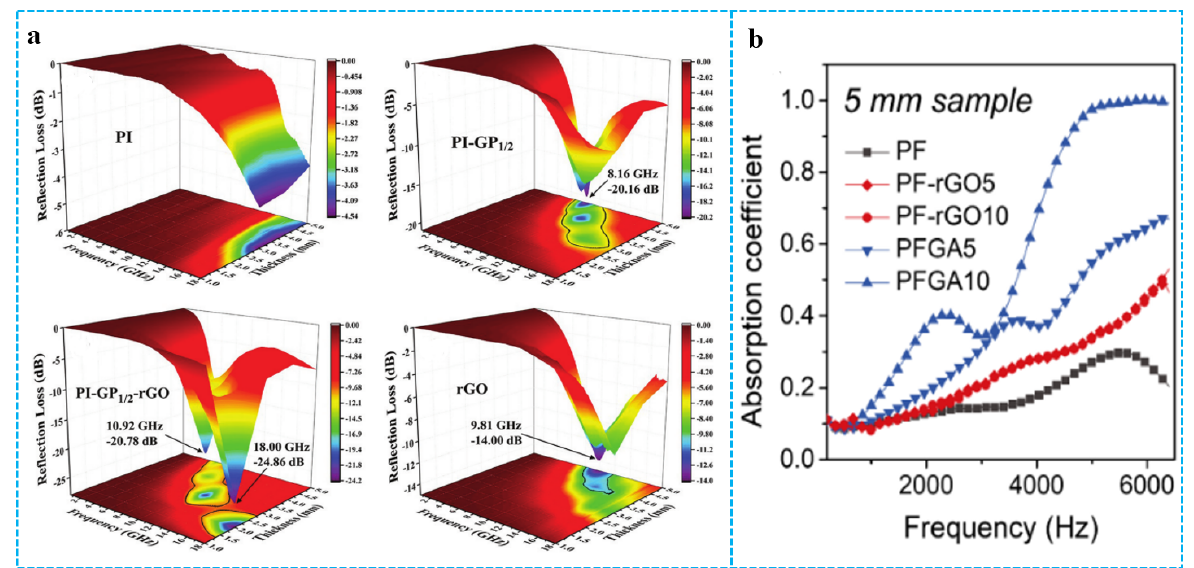
Figure 16. ( a ) 3D reflection loss maps of PI, PI − GP 1/2 , PI − GP 1/2 − rGO and RGO composite foams. Reproduced with permission from [138]. ( b ) The sound-absorption coefficients of PF, PF − RGO and PFGA at 5 mm thickness. Reproduced with permission from [57].